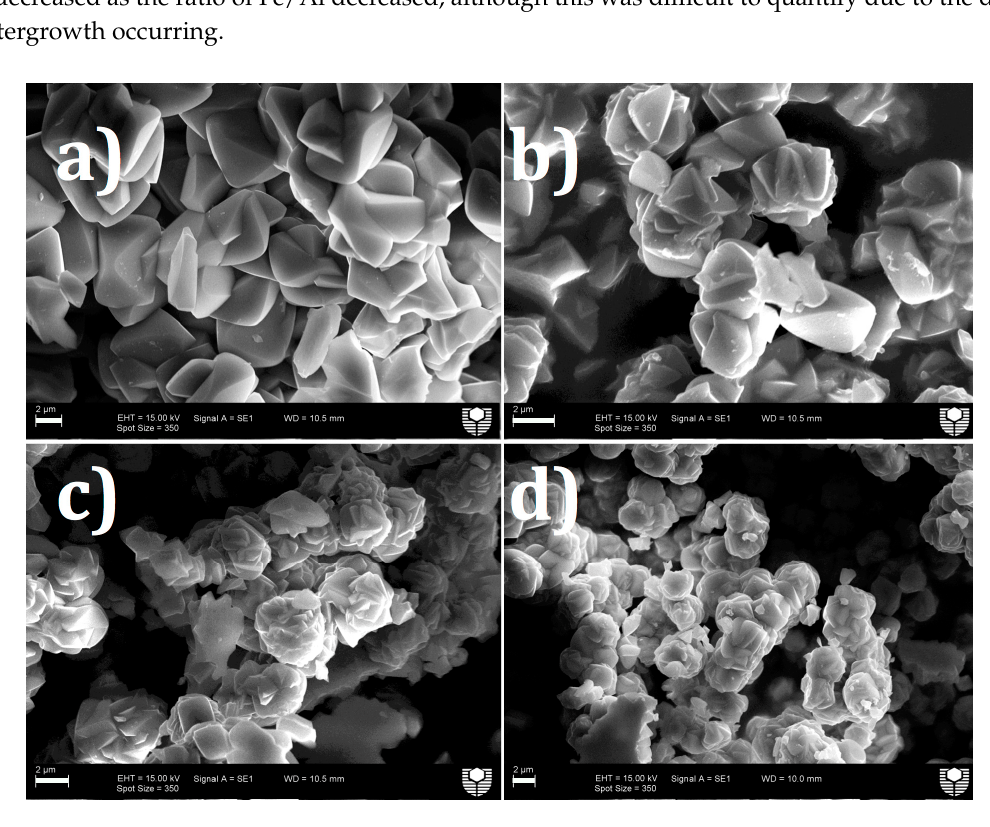
Figure 1. SEM images of jarosite particles formed for sample ( a ) jarosite A (control); ( b ) jarosite C; ( c ) jarosite D; and ( d ) jarosite F (all scale bars 2 µm).